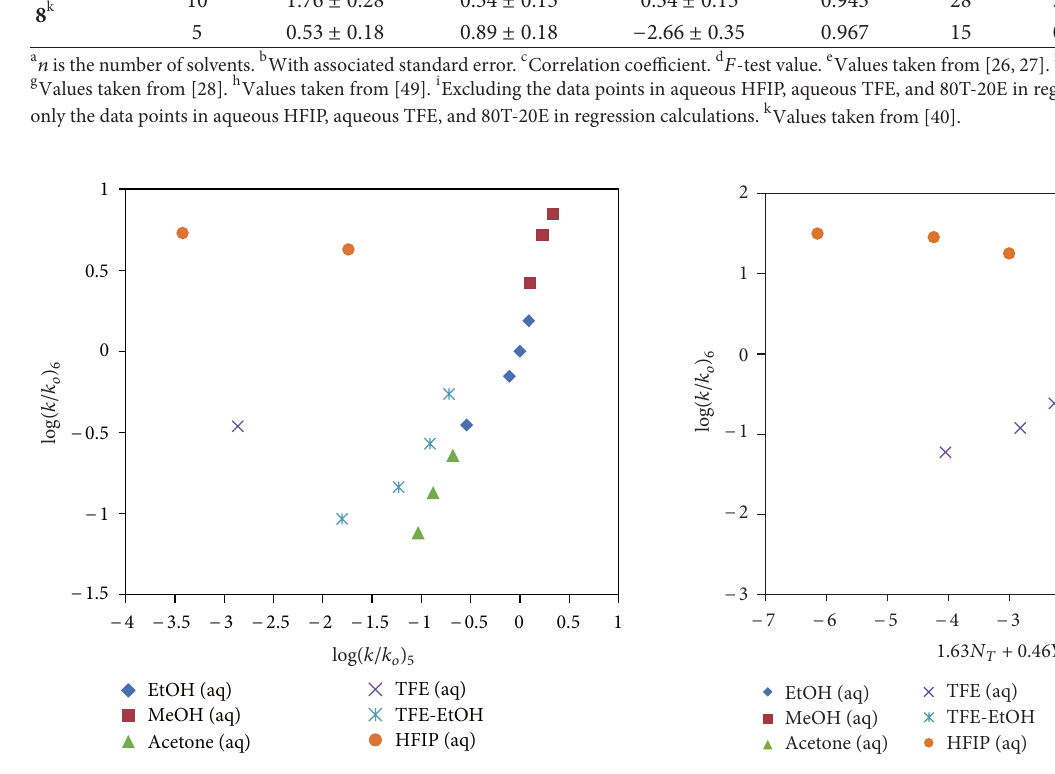
for 4-tolylphenyl chlorothionofor- + 0.46 in the twenty pure and binary Cl O and HFIP-H O are not (𝑘𝑘𝑙𝑘𝑘 𝑜𝑜 ) 𝑌𝑌 𝑁𝑁 𝑇𝑇 𝑙 𝑙